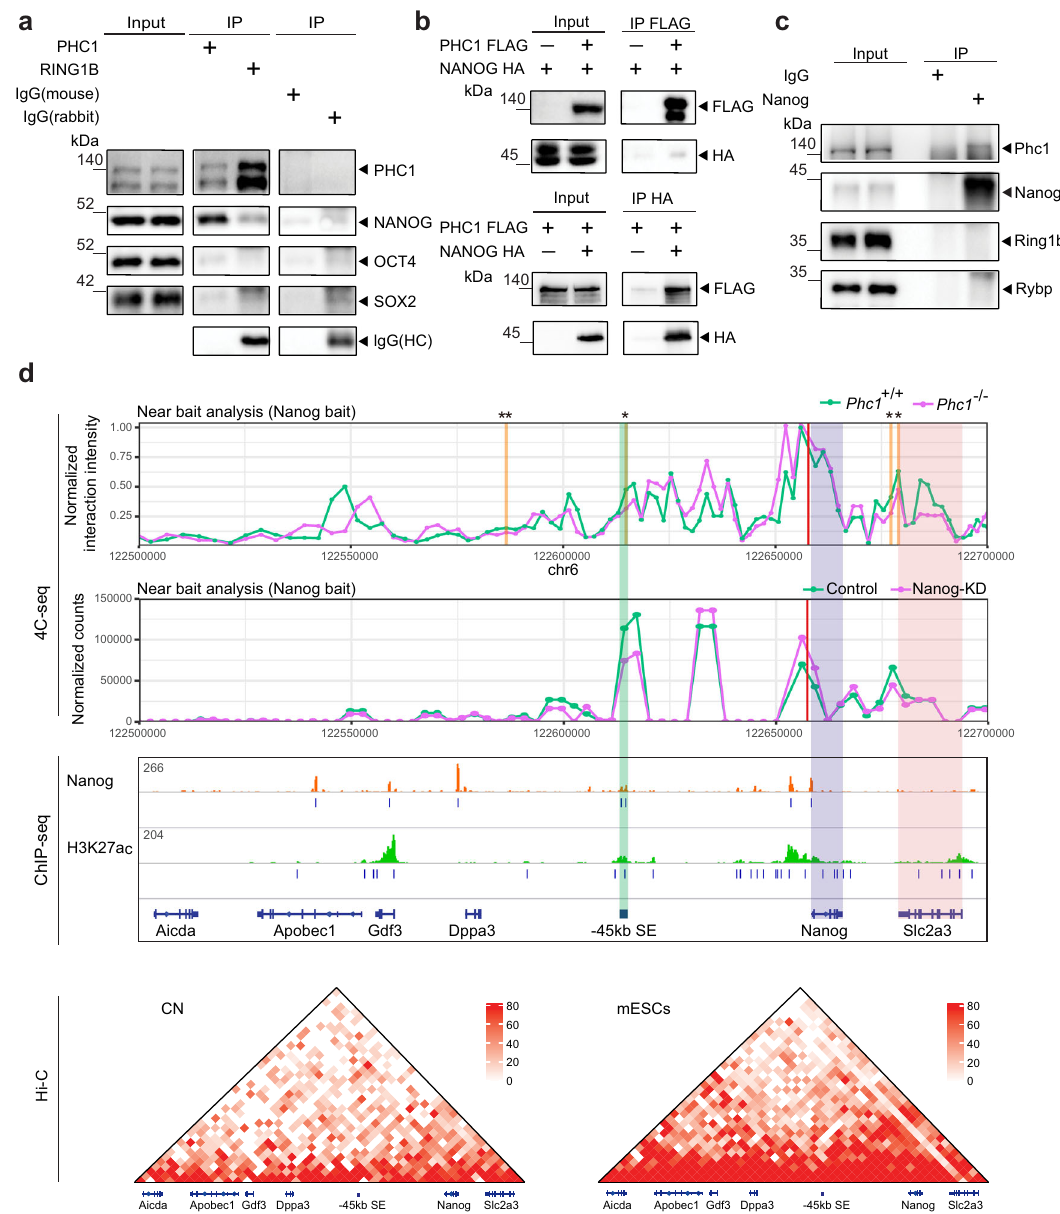
Fig. 5 PHC1 interacts with NANOG and organizes genome-wide chromatin interactions of the Nanog locus. a Co-immunoprecipitation (Co-IP) from total hESC extracts using antibodies against RING1B and PHC1 followed by immunoblotting of different proteins. b Co-IPs of nuclear extracts from HEK293T cells transfected with PHC1-FLAG and NANOG-HA followed by immunoblotting. c IP of nuclear extracts from mESCs using an antibody against Nanog and immunoblotting of Phc1, Ring1b, Rybp, and Nanog, respectively. d Top panel: Interaction pro fi le showing the normalized interaction intensity ( y axis) of regions with the Nanog promoter (anchor) in chr6: 122500000-122700000 of mm9 genome assembly ( x axis) in Phc1 + / + (green line) and Phc1 − / − (purple line) mESCs. Regions with signi fi cant decreases in Phc1 − / − than Phc1 + / + mESCs were highlighted and statistical signi fi cance was indicated with asterisk. n = 4 independent experiments. Paired single-side t -tests were used (from left to right p values are 0.0090, 0.0234, 0.0379, and 0.0304, respectively). Middle panel: Analysis of the previously published 4C-seq datasets showing interaction pro fi le of genomic regions near the Nanog promoter (empirical anchor) in chr6: 122500000-122700000 of mm9 genome assembly in control (green line) and Nanog KD (purple line) mESCs 41 ; H3K27ac and Nanog ChIP-seq binding pro fi les in the corresponding regions 8,37 . Bottom panel: Hi-C interaction matrices of mouse cortical neurons (CNs) and mESCs in chr6: 122500000-122700000 of mm9 genome assembly, respectively 58 . Source data are provided as a Source Data fi